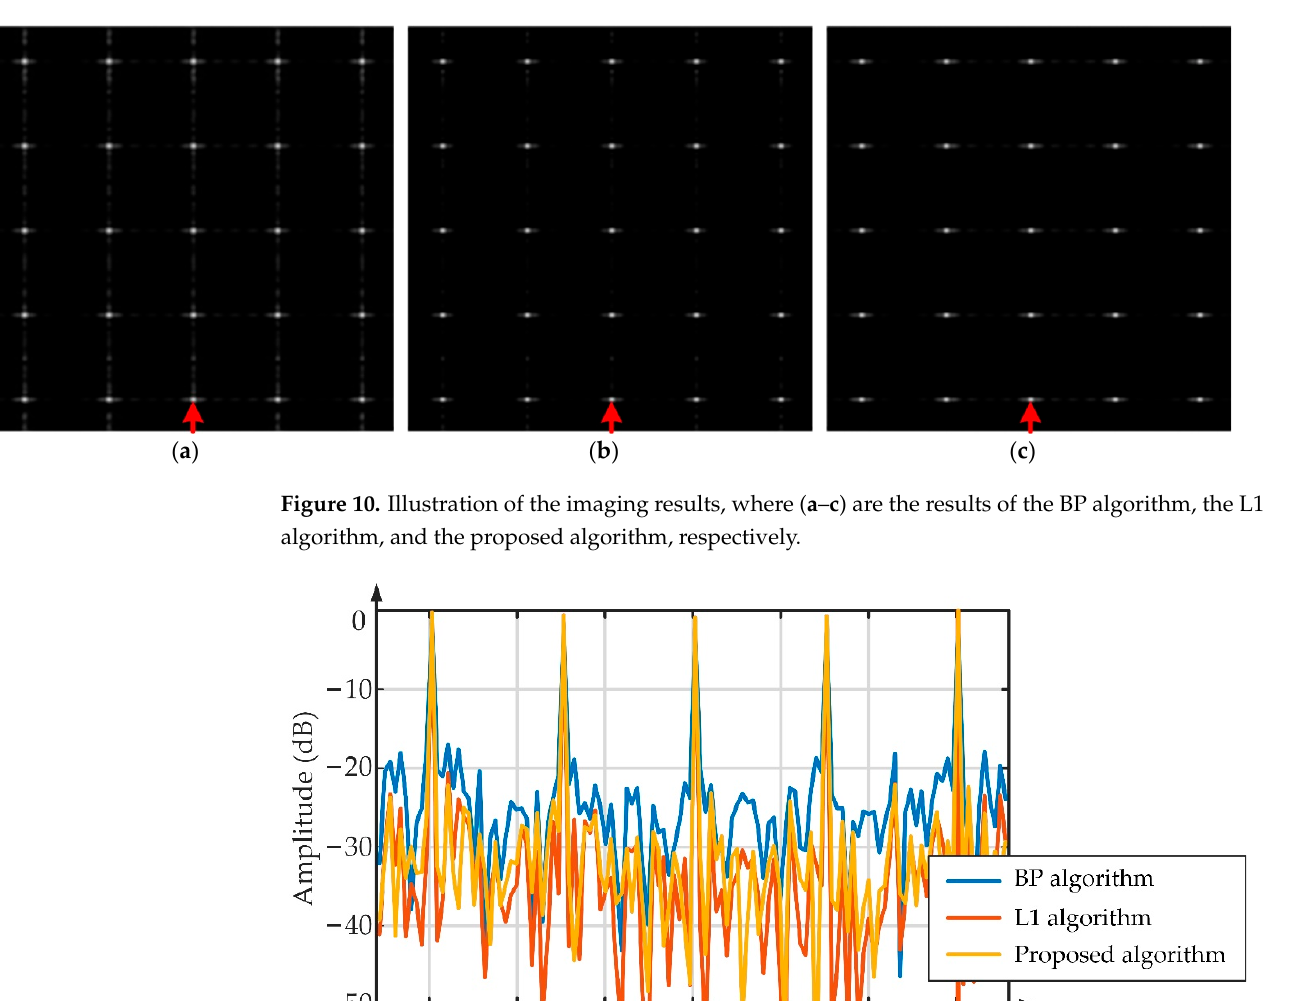
Figure 9. Illustration of the observed scene including 25-point targets.